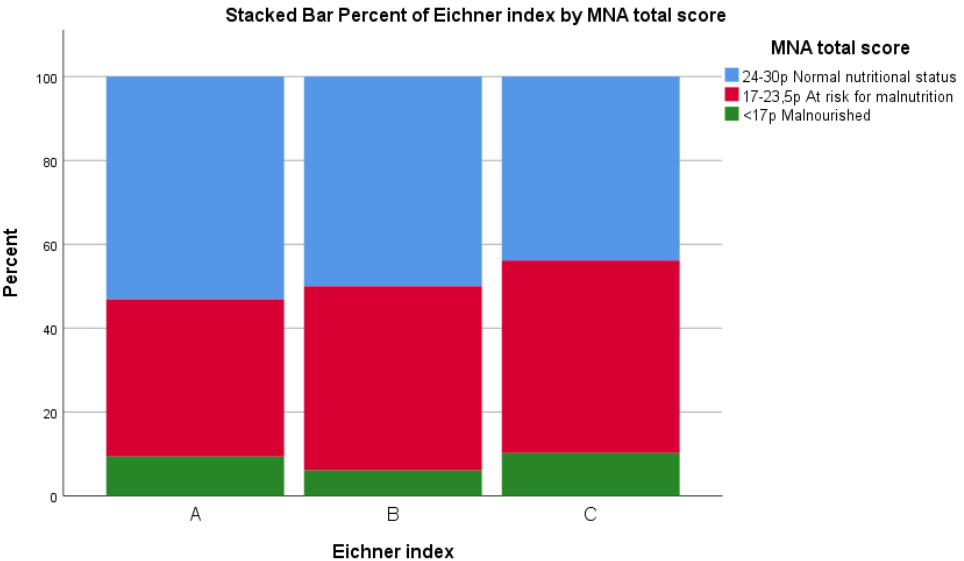
Figure 4. Total individual score of the Mini Nutritional Assessment screening tool. Participants grouped according to the Eichner index, which measures number of occluding teeth. ( A ) = four occluding zones, ( B ) = one to three occluding zones or presence of occlusal contacts frontally, and ( C ) = no occluding teeth.